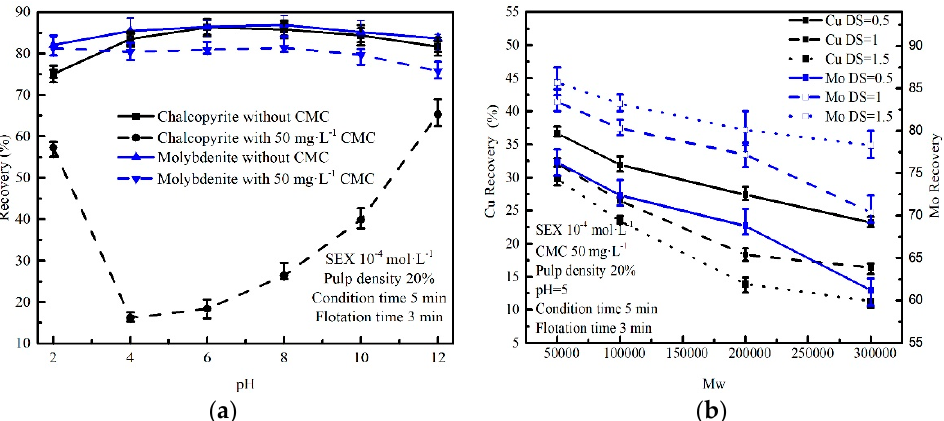
Figure 2. ( a ) Effects of pH and ( b ) molecular weight (with varying degree of substitution) on chalcopyrite and molybdenite flotation in the CMC system.